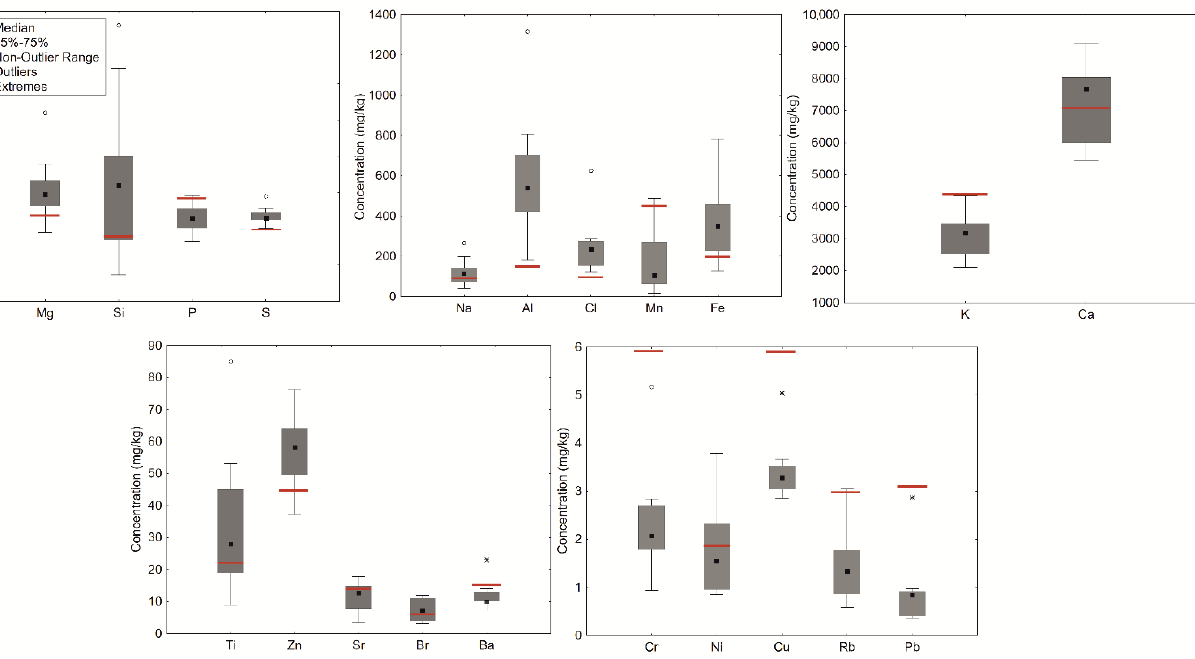
Figure 4. The results of pine needle samples analysis by the WDXRF (Na, Mg, Al, Si, P, K, Ca, Ti, Mn, Fe, S, Cl, Br, Ba) and TXRF (Cr, Ni, Cu, Zn, Rb, Sr, Pb) techniques. Note: the red line presents the background values.